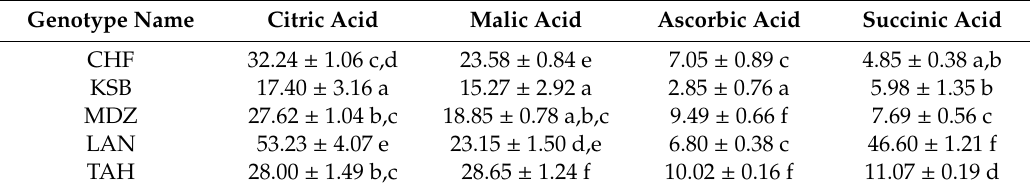
Table 3. Composition of organic acids and ascorbic acid (g / 100 g DW) in fruits of strawberry tree